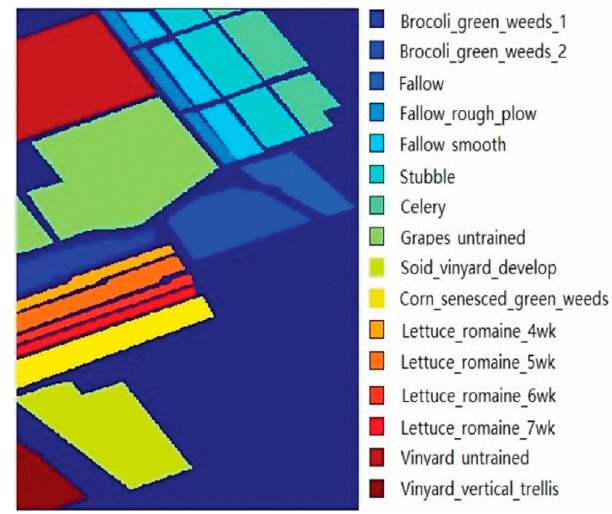
Figure 4. Ground truth map of the Salinas data set.